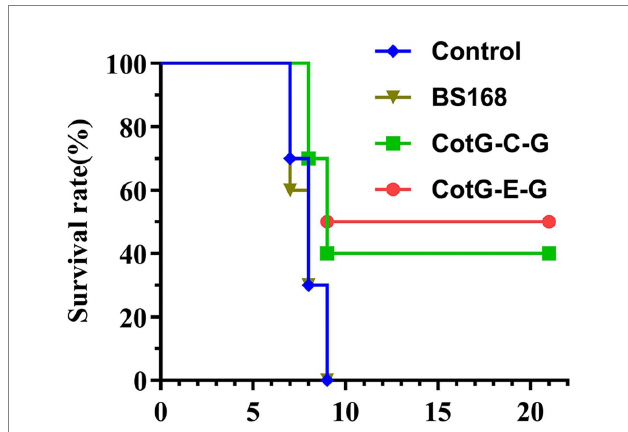
FIGURE 5 Protection of recombinant B. subtilis against lethal RABV challenge. Groups of mice ( n = 10) were challenged with 100 × IMLD50 of RABV street strain 4 weeks after the last immunization. Observed for 21 days. The survival of mice in each group at different times after the challenge was recorded. The p value between BS168 and CotG-E-G group was 0.071, and BS168 and CotG-C-G group was